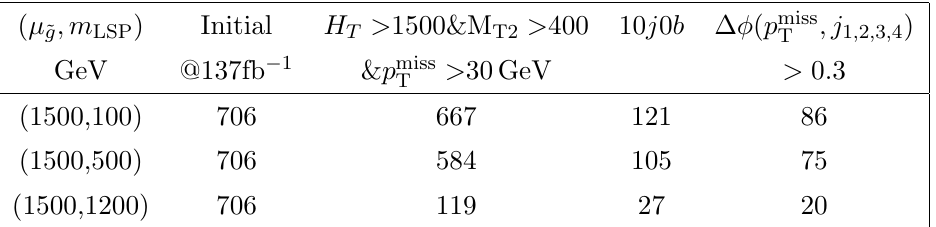
Table 1. Cut(cid:13)ow for the benchmark study, which looks at the 10 j 0 b bin from CMS’s inclusive M T2 search using 137fb (cid:0) 1